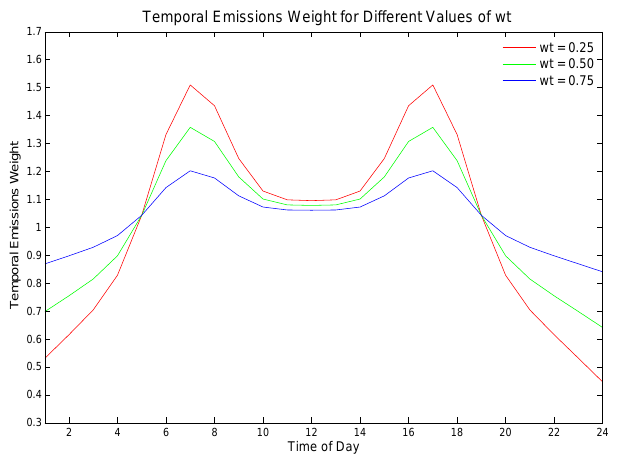
Fig. 3. The temporal weight of emissions (normalized to unity), as a function of time, for an urban area. Specifically, this is the emission time distribution obtained for the input variable wt = { 0 . 25 , 0 . 50 , 0 . 75 } .